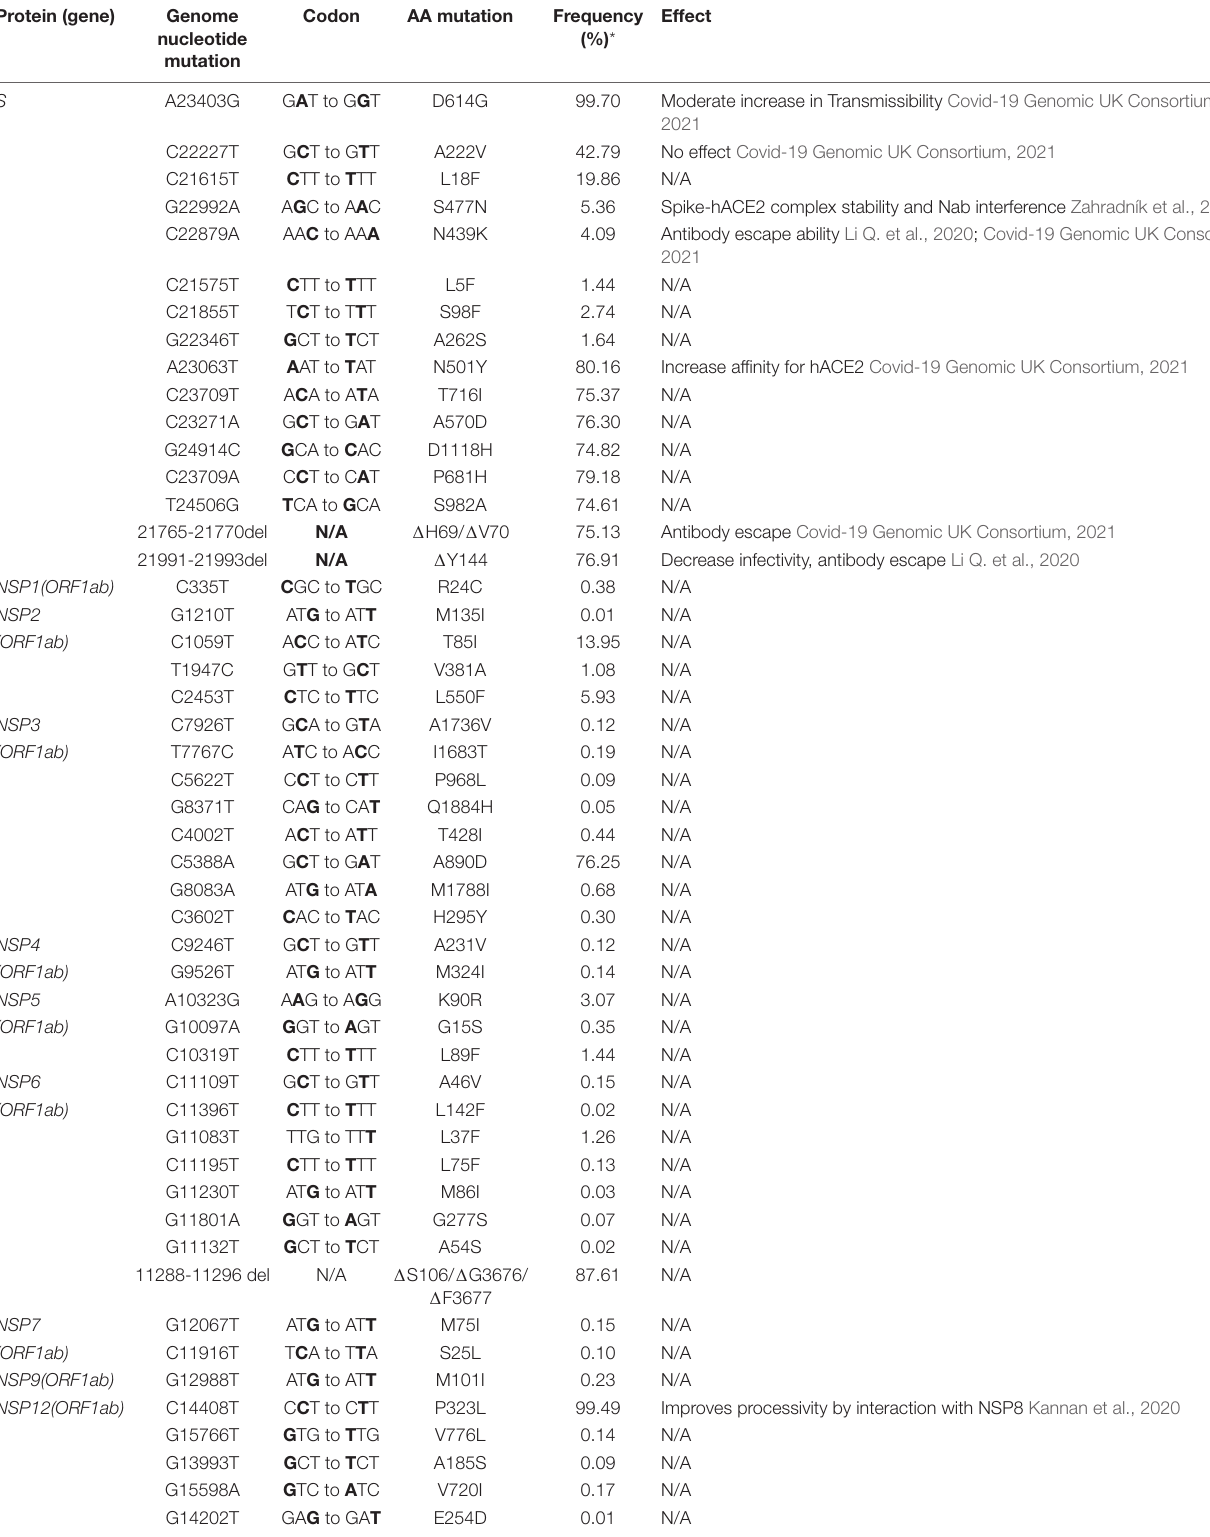
TABLE 1 | Non-synonymous mutations in severe acute respiratory syndrome coronavirus-2 (SARS-CoV-2) genes with a worldwide frequency ≥ 0.01%. Protein (gene) Genome